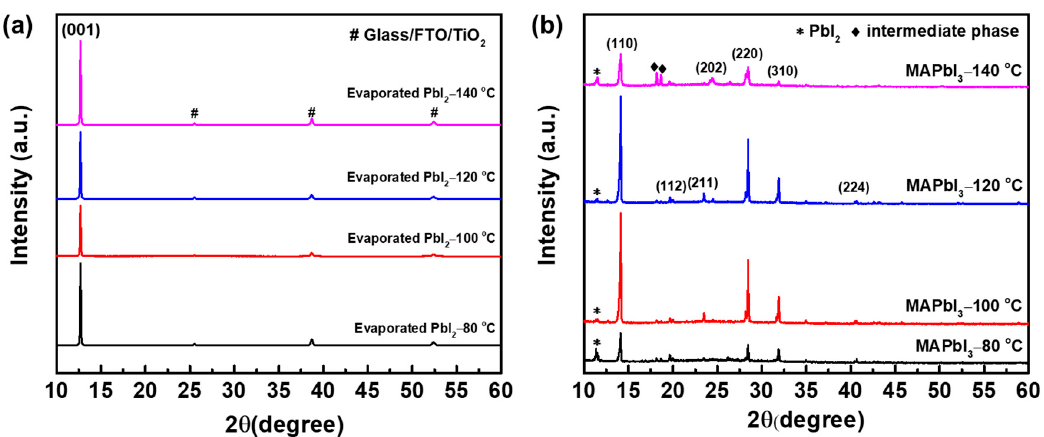
Energies 2021 , 14 , x FOR PEER REVIEW Figure 4. ( a ) The XRD spectrum of the PbI 2 /TiO 2 /FTO structure at treatment temperatures of 80, 100, 120, and 140 ◦ C. ( b ) The XRD spectrum of the MAPbI 3 /TiO 2 /FTO structure at treatment temperatures of 80, 100, 120, and 140 ◦ C.